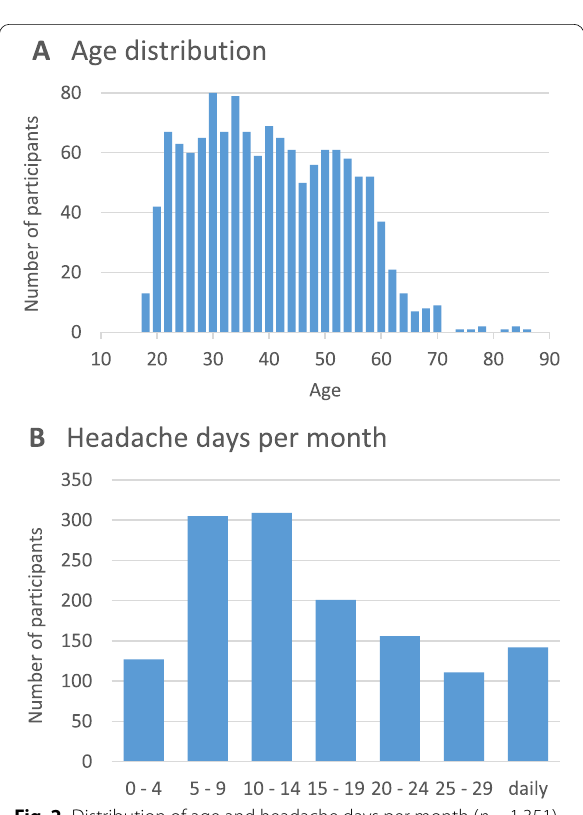
Fig. 2 Distribution of age and headache days per month ( n